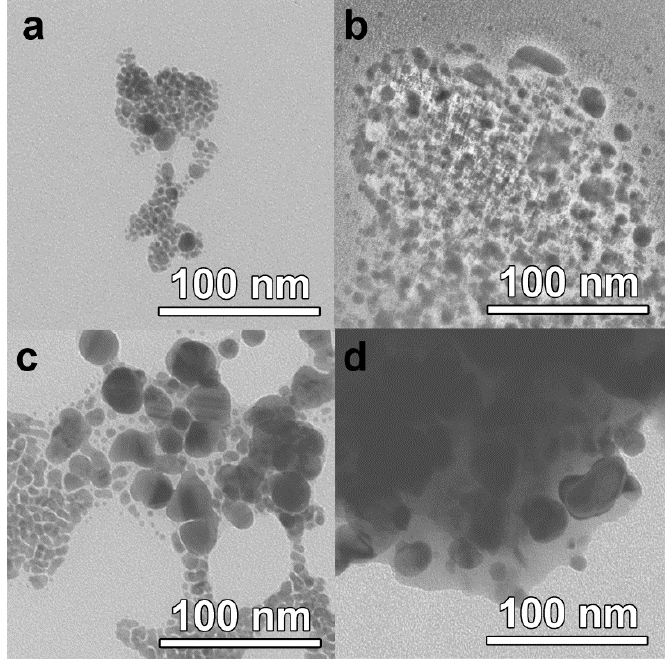
Figure 3. Transmission electron microscopy (TEM) images of silver nanoparticles prepared via UV-activated reduction of silver citrate complex in 1H 2 O:1EG solvent: ( a ) 8 min photoreduction in bulk solution; ( b ) 8 min photoreduction on quartz slide; ( c ) 28 min photoreduction in bulk solution; and ( d ) 28 min photoreduction on quartz slide.